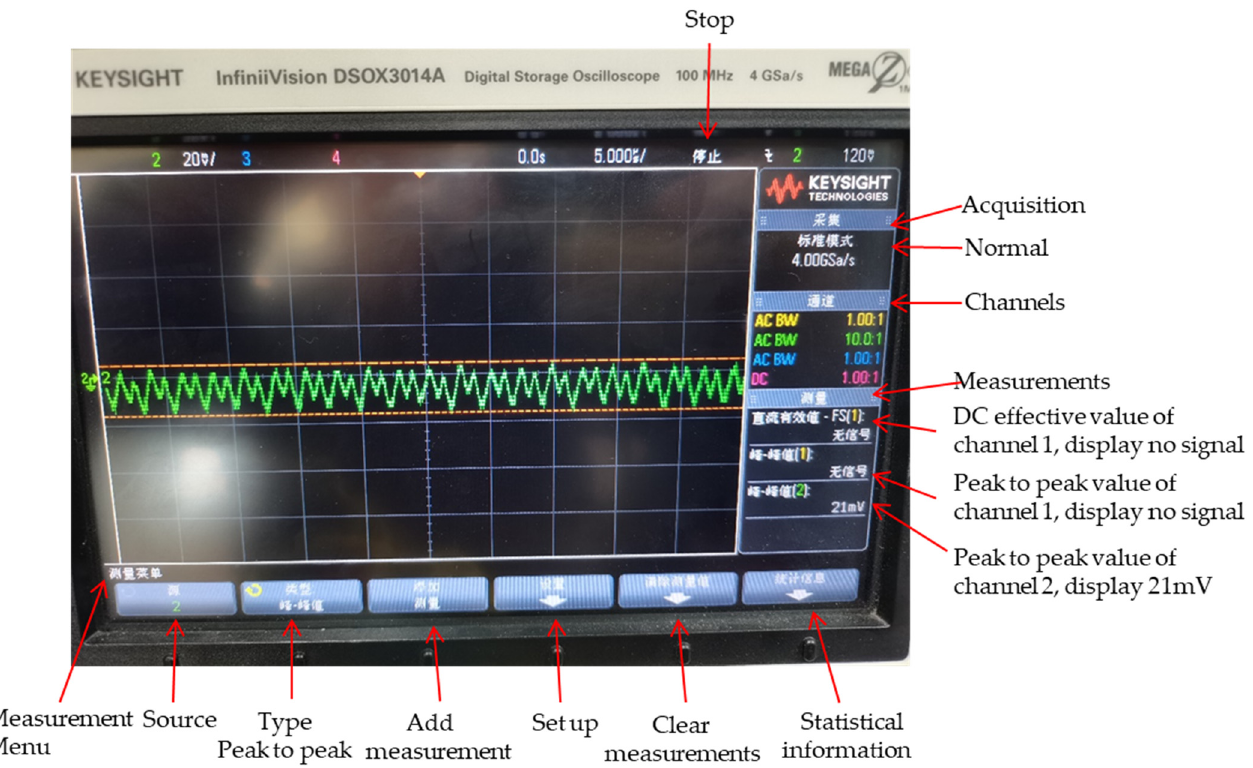
Figure 7. The ripple of input 6 V power supply for generate VDD5A.